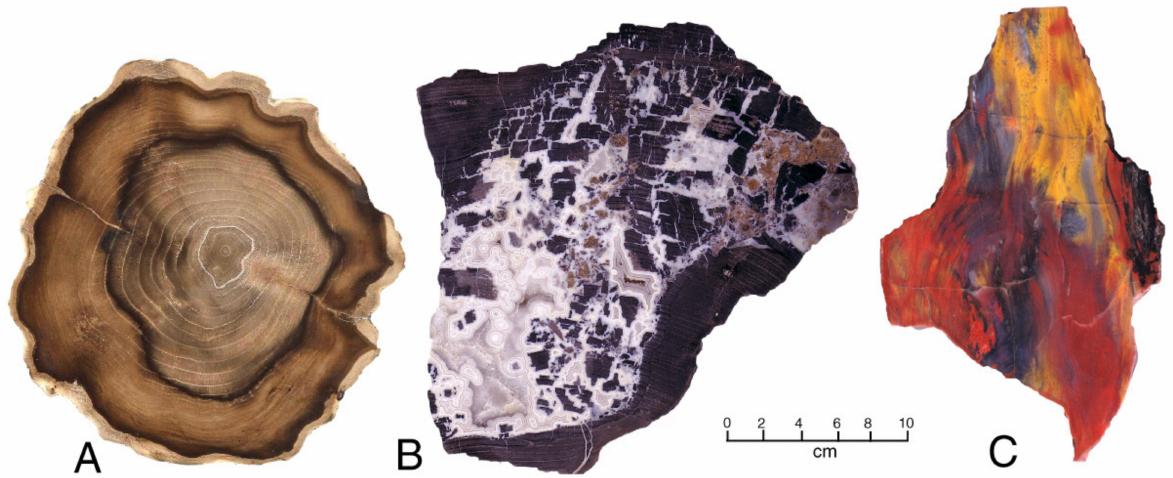
Figure 15. Polished slabs provide important clues for understanding the mineralization of fossil wood. ( A ) Miocene cherry wood from Hubbard Basin, northern Nevada/southern Oregon, USA. Color patterns come from variations in trace element concentrations. ( B ) Eocene wood from Tom Miner Basin, Gallatin National Forest, Montana, USA [57]. This wood had been fragmented by fungal rot prior to fossilization. Voids became filled with white chalcedony. ( C ) Triassic wood from Chinle Formation, northern Arizona, USA. The variegated colors are caused by trace amounts of iron in varying concentrations and oxidation states